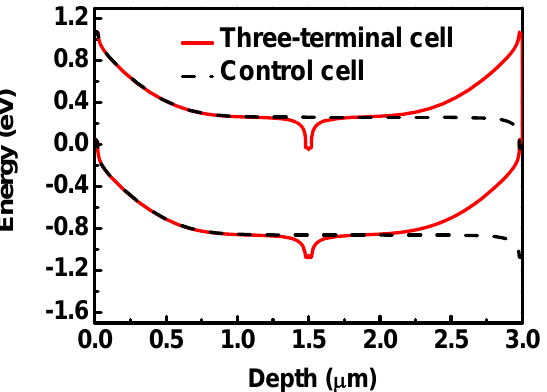
Figure 3. The band diagrams of the three-terminal cell and the control cell. The photo-generated electrons and holes drift to the n-layers and p-layers, respectively.